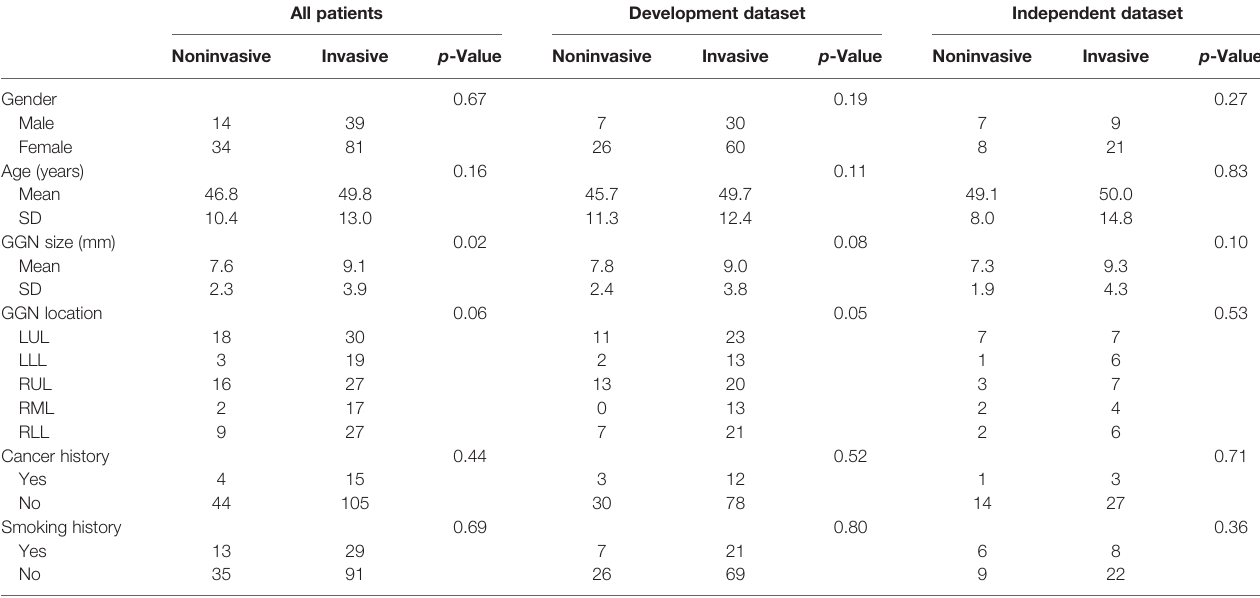
TABLE 1 | The clinicopathologic characteristics of enrolled patients. All patients Development